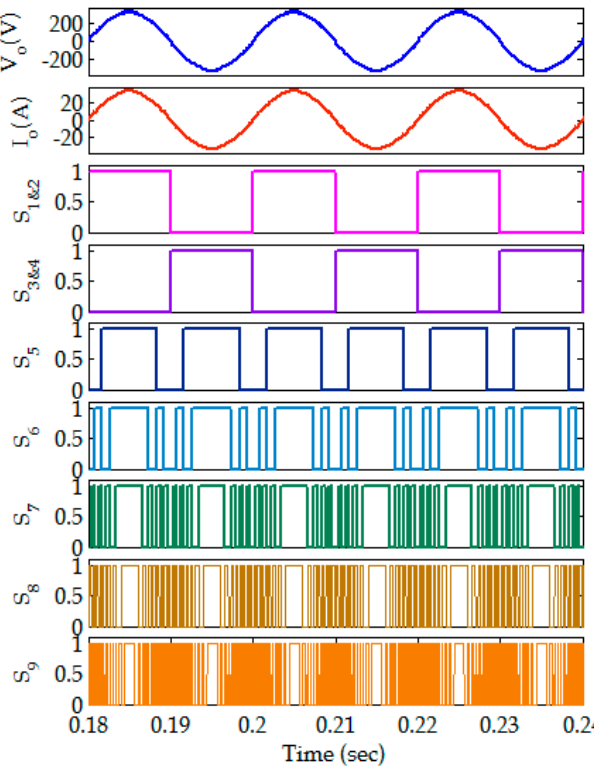
Figure 6. Output waveforms and switching pattern of reduced switch 63 − level MLI.